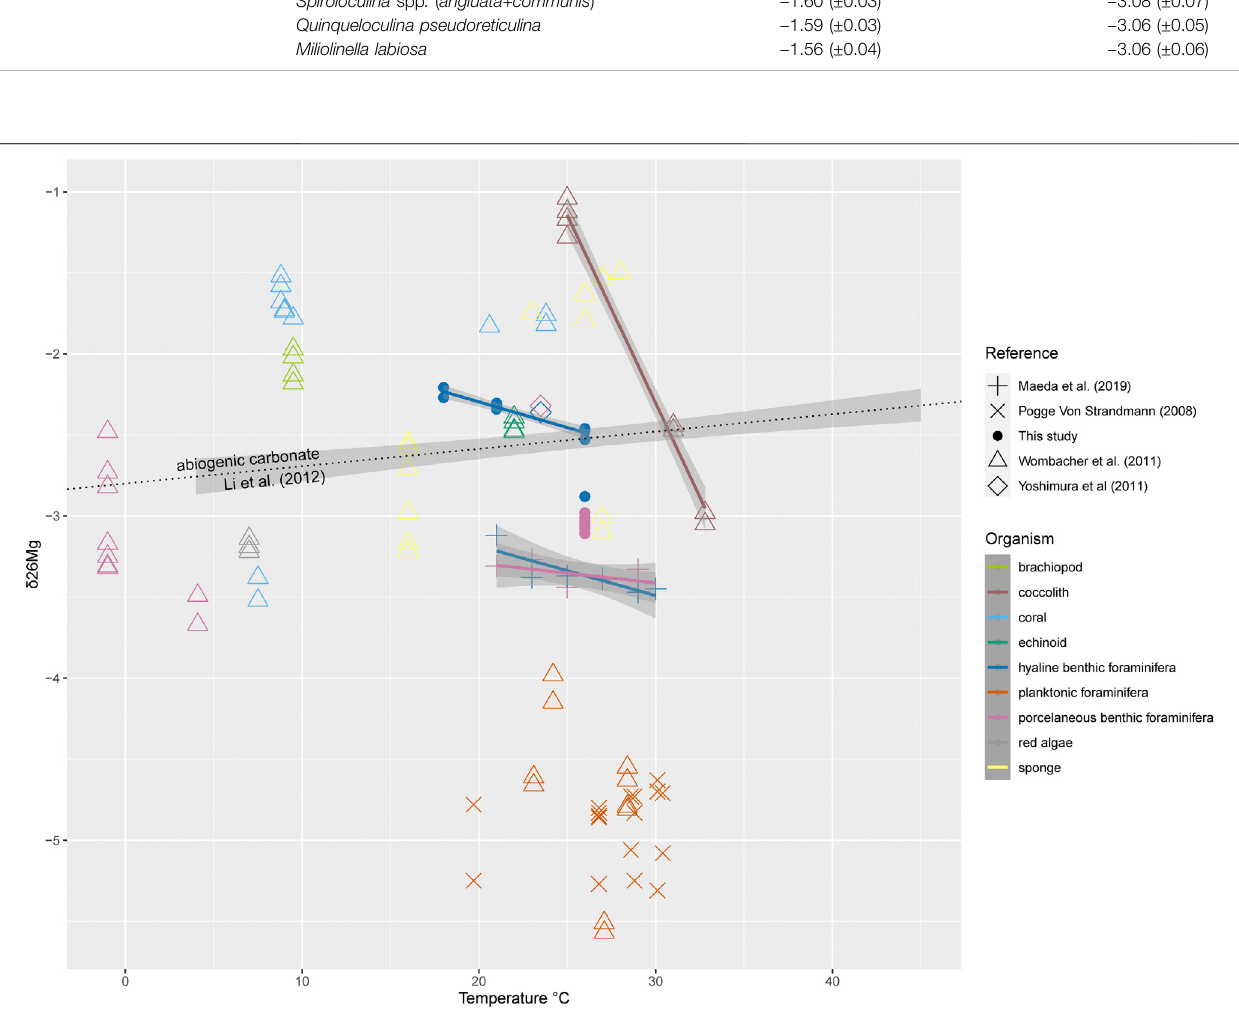
FIGURE 3 | δ 26 Mg values versus temperature for different organisms from literature data (Maeda et al., 2019; Pogge von Strandmann, 2008; Wombacher et al., 2011; Yoshimura et al., 2011) and this study, showing different responses between groups of organisms. In addition to species speci fi c relationships in benthic foraminifera (see Figure 1 ), a statistically signi fi cant relationship ( p -values < 0.05) can be observed for coccoliths ( δ 26 Mg (cid:2) − 0.23*T+ 4.66, R 2 (cid:2) 0.98), and sponges ( δ 26 Mg (cid:2) 0.07*T − 4.0, R 2 (cid:2) 0.34), while other groups such as corals show no clear trend and the δ 26 Mg values in abiogenic carbonates rise with temperature (Li et al., 2012). Error bars for Amphistegina lessonii are shown in Figure 2 .